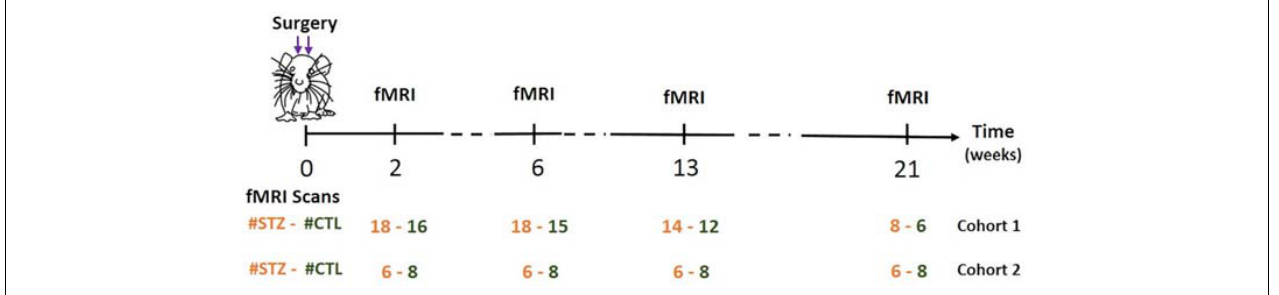
FIGURE 1 | Timeline of experiments. Two fMRI runs were acquired per rat for each experiment. Figure adapted from Tristão Pereira et al. (2021), NeuroImage 2021, with